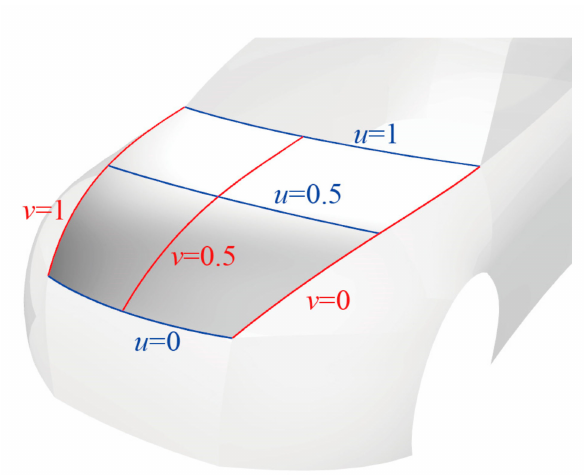
Figure 12. The key isocurves of hood surfaces in the model M0.